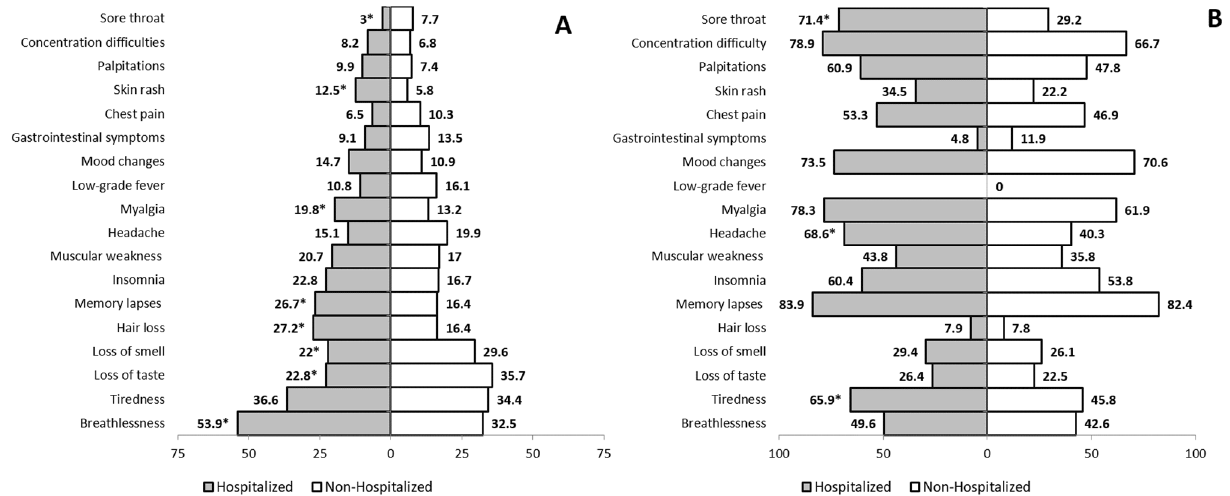
Figure 2. Percentages of patients presenting with specific coronavirus disease 2019 (COVID-19)-related symptoms at any point during the year after the acute phase of the disease ( A ); and continuation of the reported symptoms one year after acute COVID-19 in variable proportions ( B ). * denotes statistically significant differences ( p < 0.05).